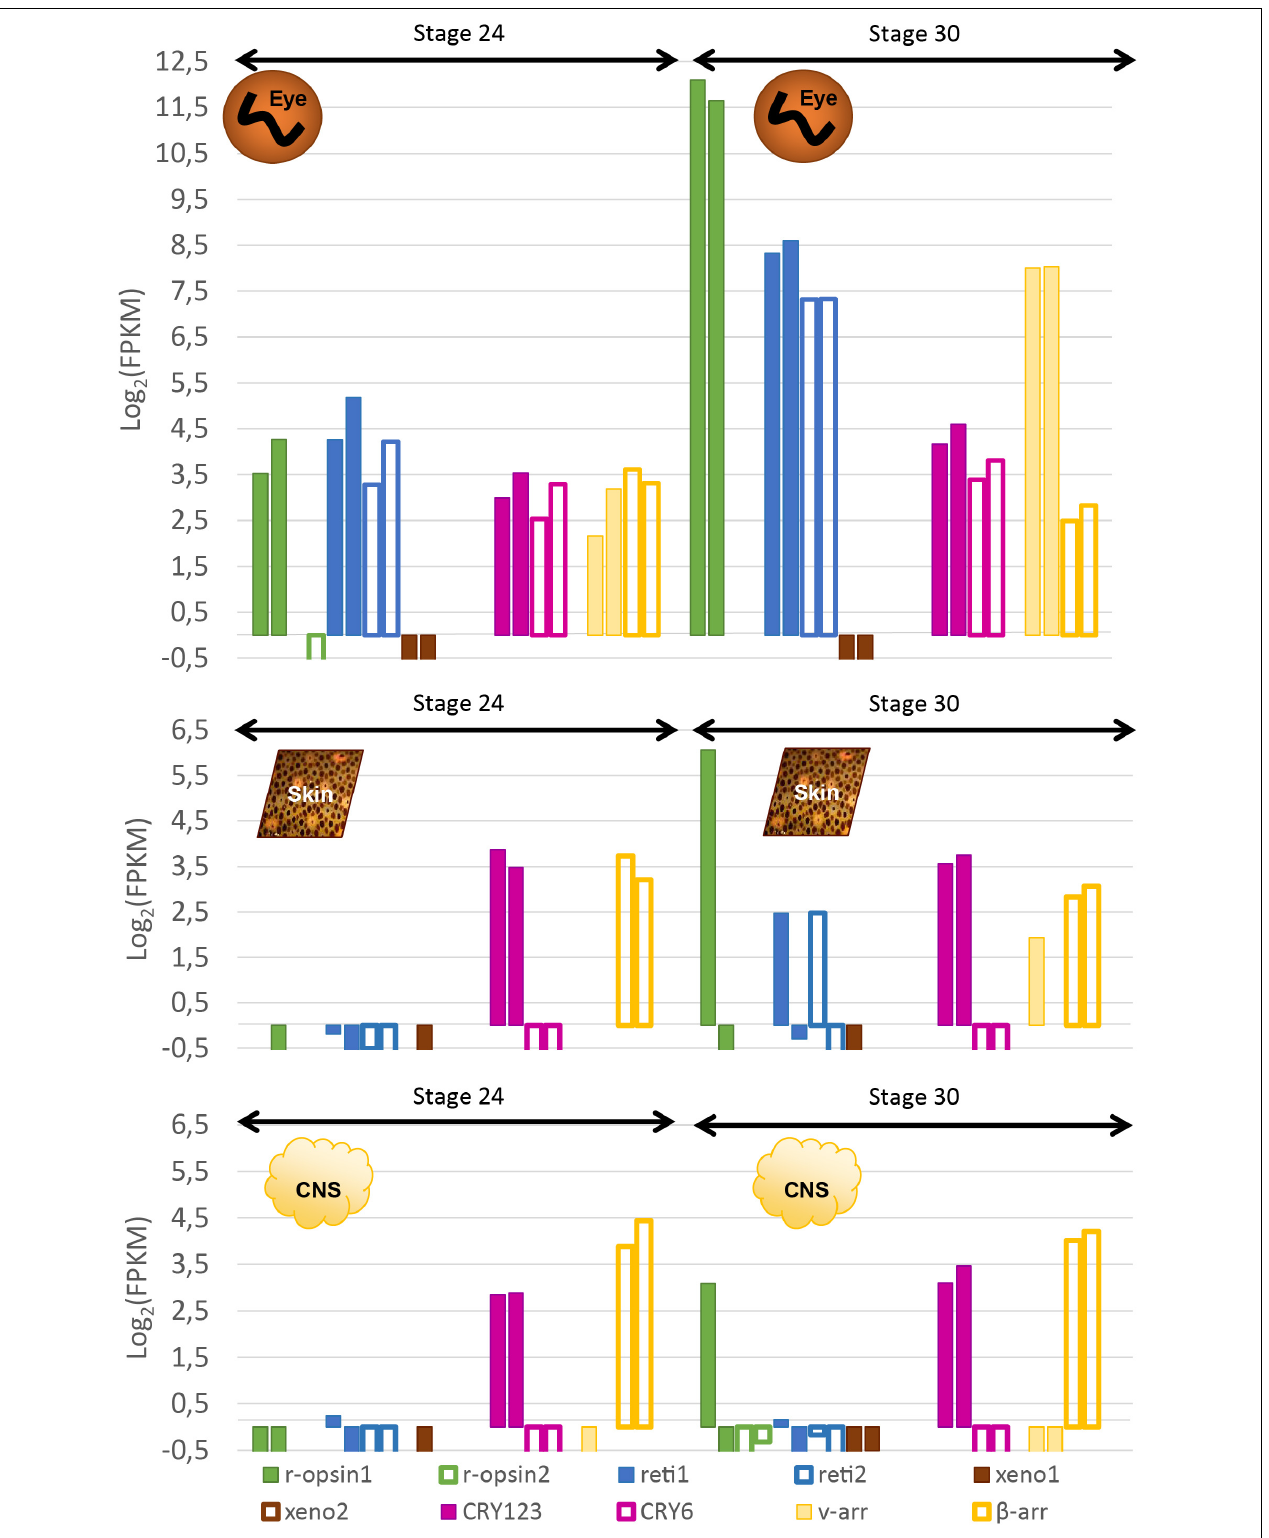
FIGURE 7 | Expression of light sensitive molecules in the eyes, skin and CNS of Sepia embryos. Expression is given in Log 2 (FPKM) and are normalized with RSEM in order to compare between stage 24 and stage 30 in the eyes (top) , the skin (middle) and in the central nervous system (brain + OL _ bottom ). For each gene, there are two bars each giving the expression in one of the two biological duplicates. The expression level of several isforms were summed up for some of the genes.